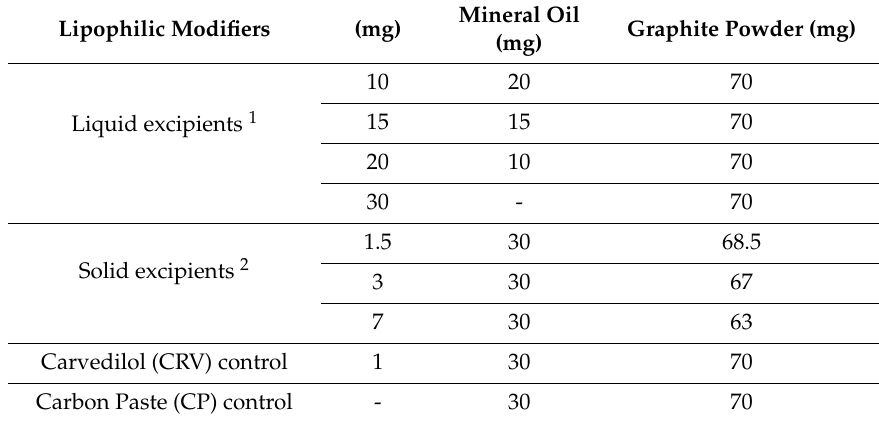
Table 1. Carbon paste compositions for stability assays.